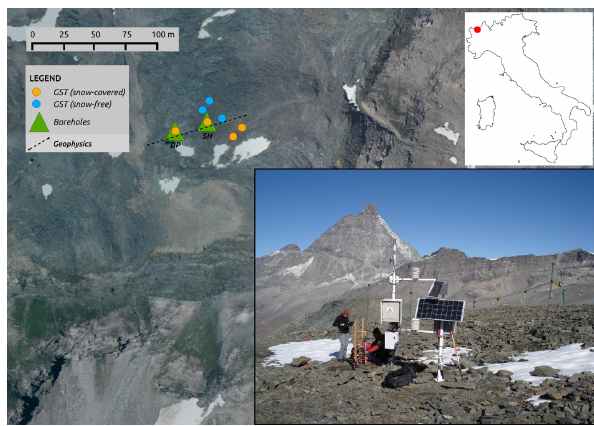
Figure 1. Overview of the Cime Bianche monitoring